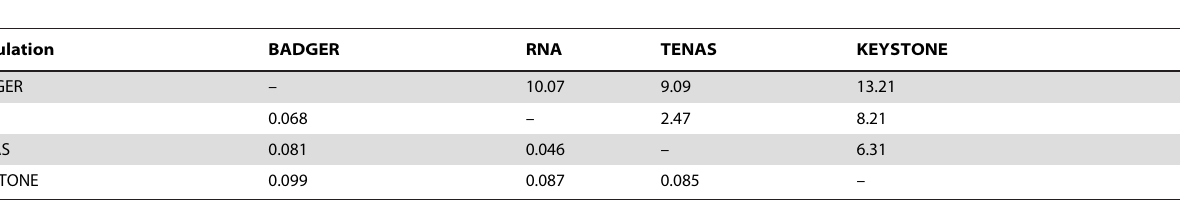
Table 4. Geographic distance (km) between each location (above diagonal) and population pairwise PhiPT values (below diagonal) based on samples collected in 2004 and 2009 (Values significant at P ,